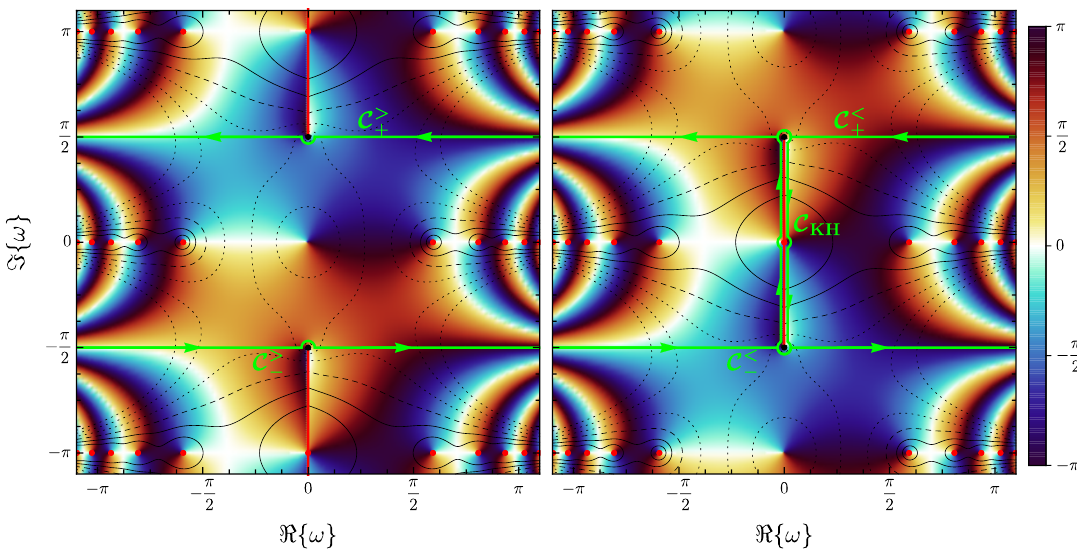
Figure 5: Complex structure of the contour integrands in the hyperbolic ω -plane + x ) / ( 2 Γ )] in the unordered phase (left, for the alternating sum over the ln [( Γ m m x δ > 0, (2.47a)) and in the ordered phase (right, x δ < 0, (2.49a)), together with the corresponding contours C ≷ . In the unordered phase, the pole at ω = 0 and the logarithmic cut at [ − i π/ 2, + i π/ 2 ] have to be excluded in order to fit with the related summation in (2.37b), thus the additional keyhole contour C . For the colour coding KH see Fig.